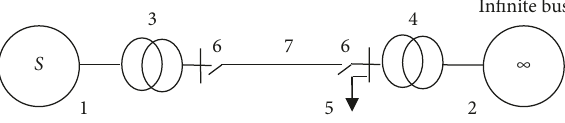
Figure 1: SMIB power system with two kinds of